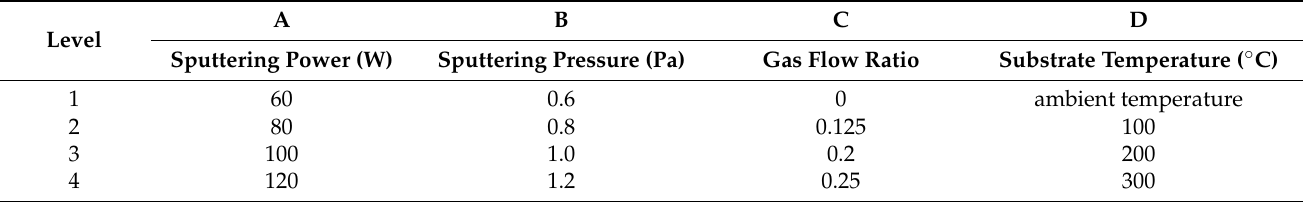
Table 3. Level table of orthogonal test factors of Si 3 N 4